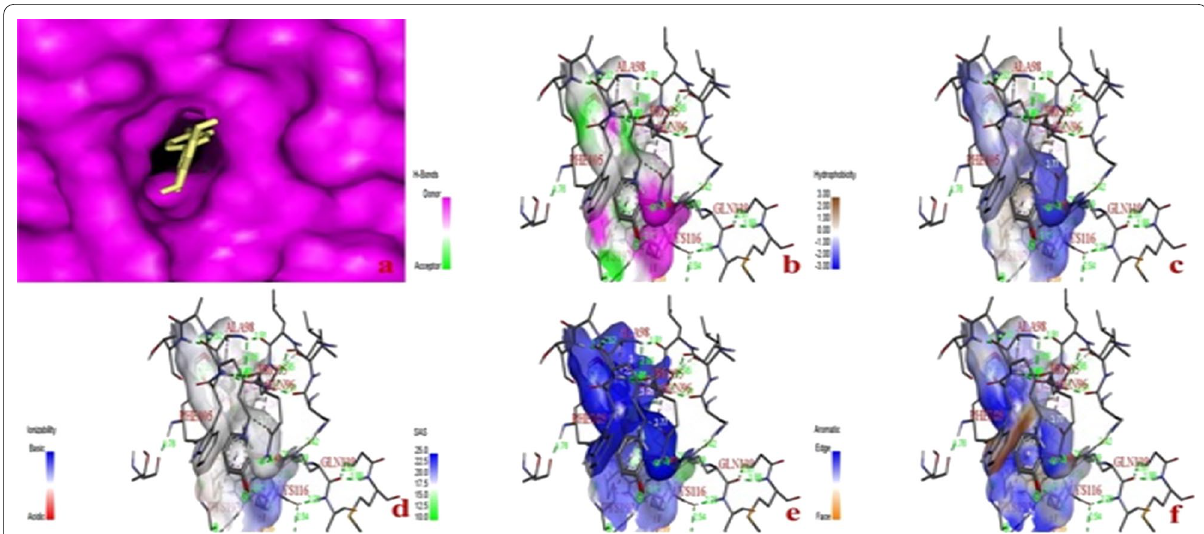
Fig. 3 Luteolin docking with V2R and cavity properties.. a PyMol docked view. b cavity H-bond view. c Cavity hydrophobicity view. d Cavity ionizability view. e Show good solvent accessibility. f Aromaticity